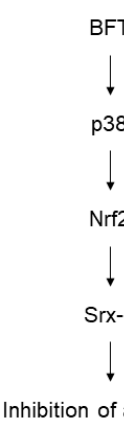
Figure 9. Schematic summary indicating BFT-induced signaling involved in Srx-1 induction and apoptotic inhibition in IECs.